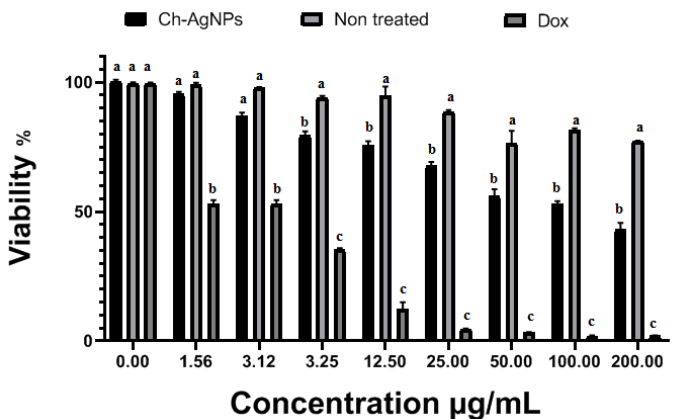
Figure 8. In vitro cytotoxicity effects on Chi/Ag-NPs and doxorubicin against normal human skin cell line (BJ-1) was assessed by SRB colorimetric assay. Within each column, different letters indicate significant differences among values ( p < 0.05) based on one-way ANOVA estimated by GraphPad Instat software, (version 6.01), San Diego, CA, USA.